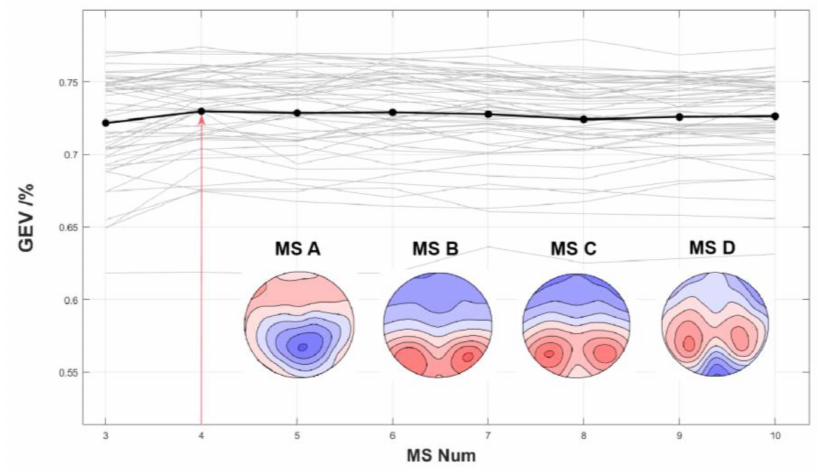
Figure 3. Topographies of the five global microstates across conditions and